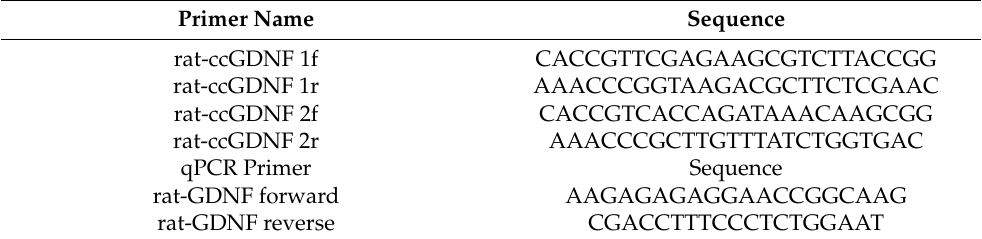
Table 2. Primers to verify genetic alterations by